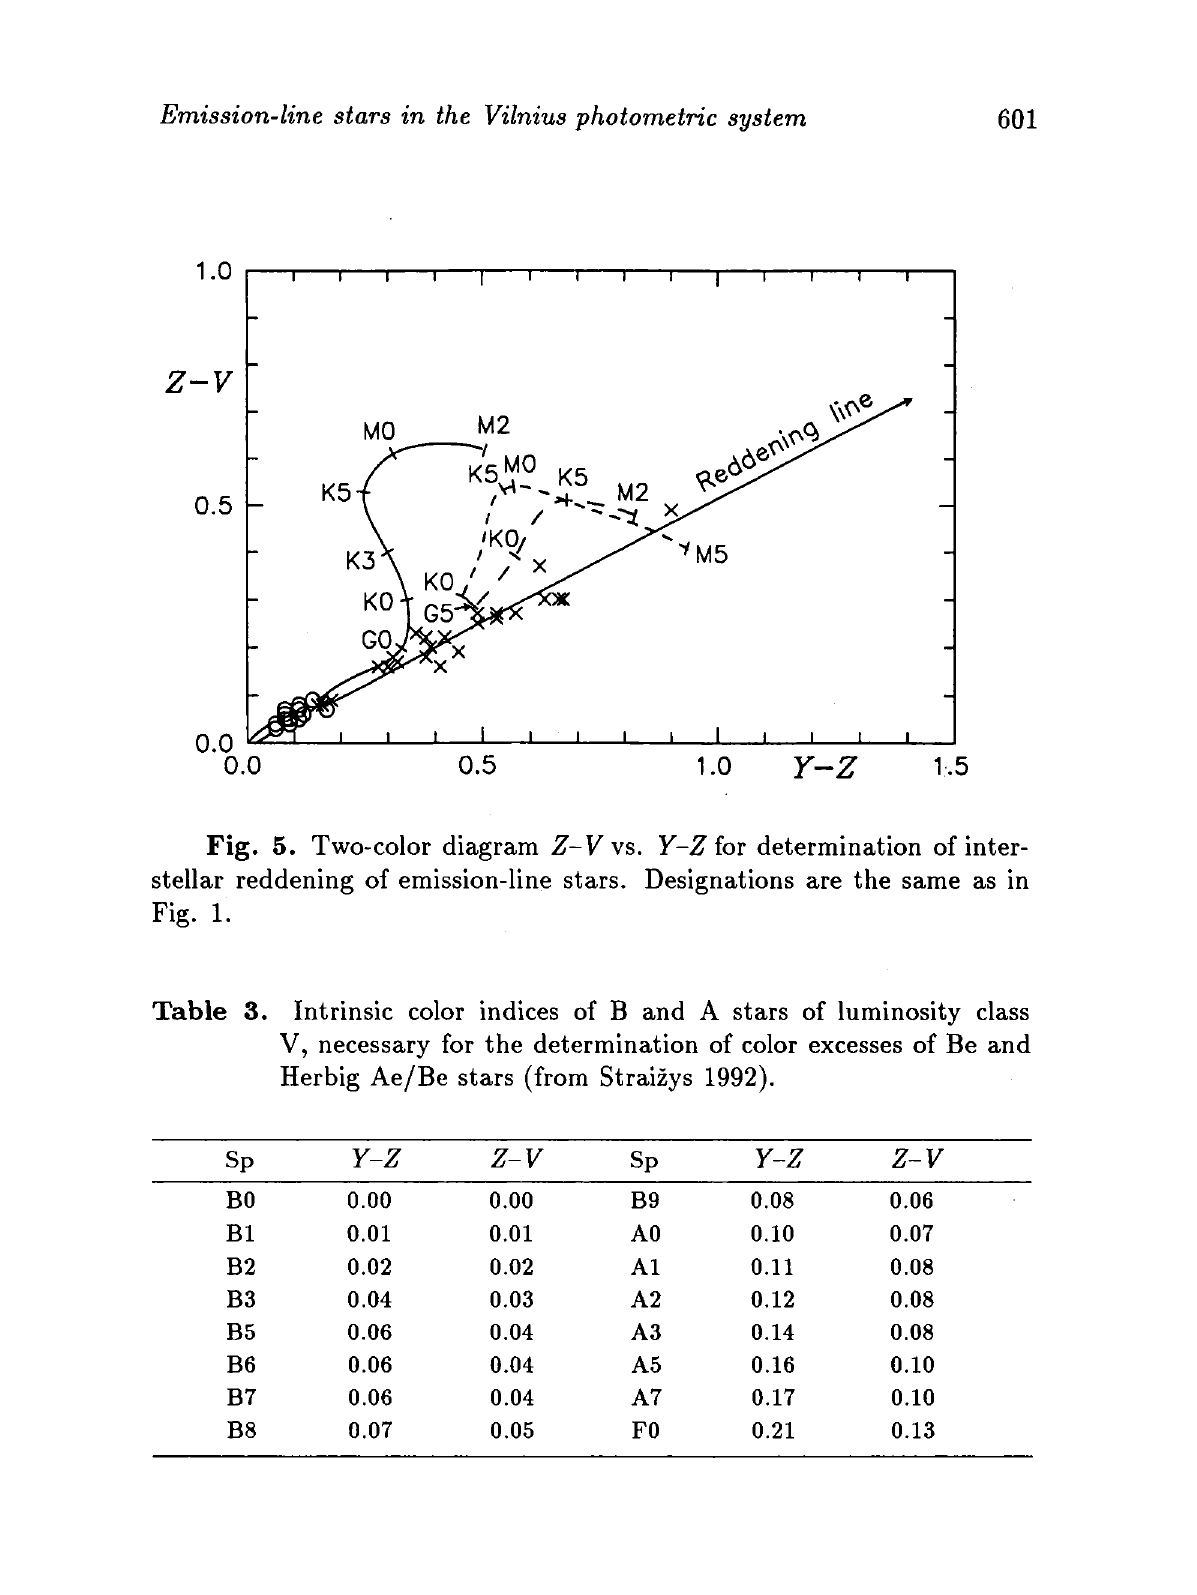
Table 3. Intrinsic color indices of Β and A stars of luminosity class V, necessary for the determination of color excesses of Be and Herbig Ae/Be stars (from Straizys